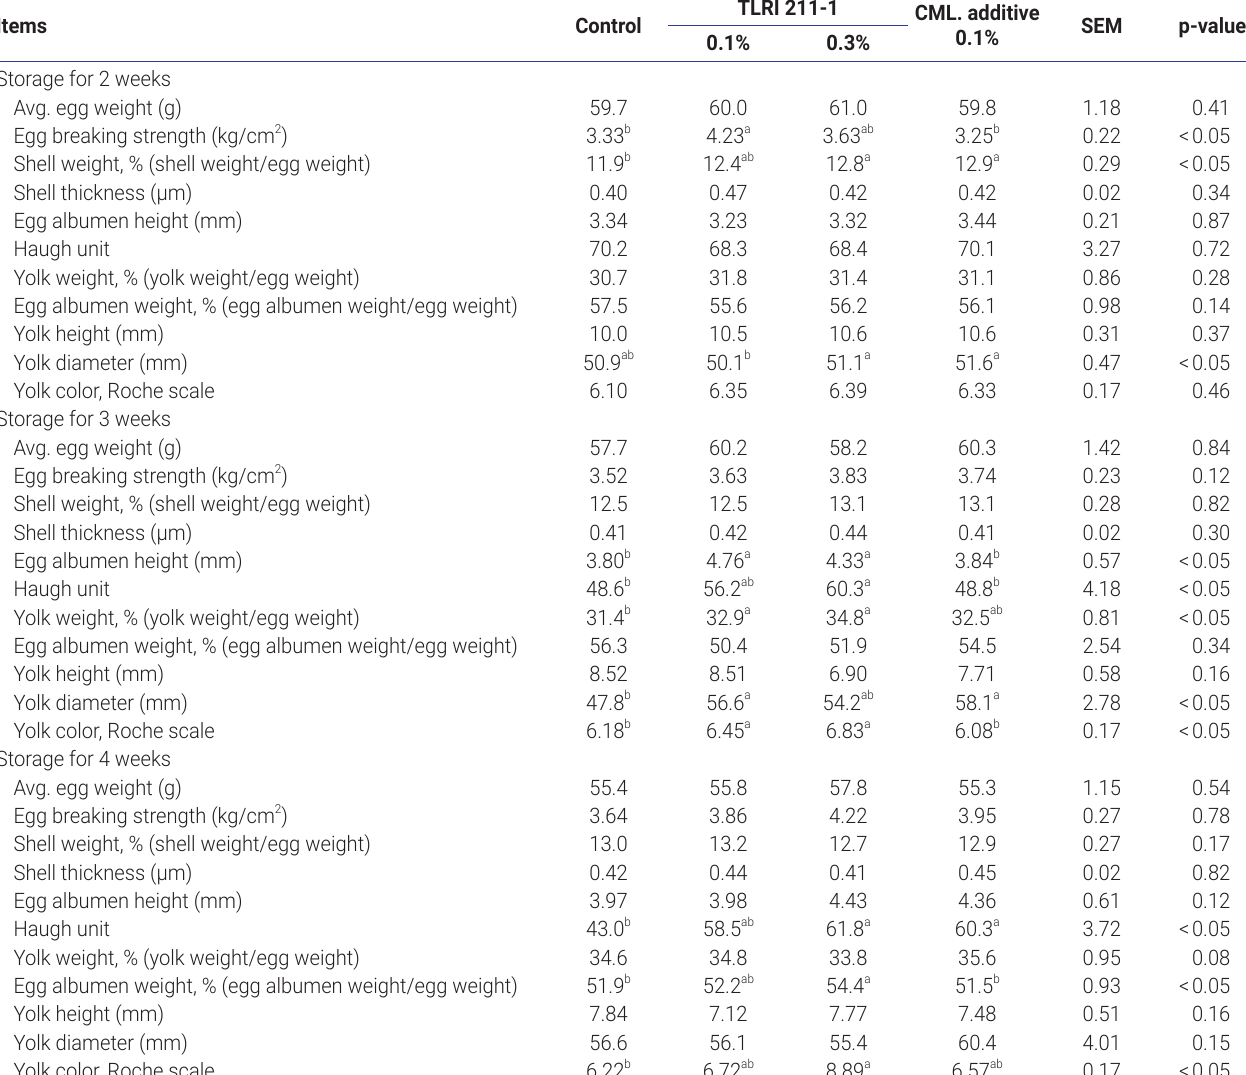
Table 5. Effects of dietary supplementation of Bacillus subtillis and B. amyloliquefaciens on egg quality of Leghorn laying hens during storage